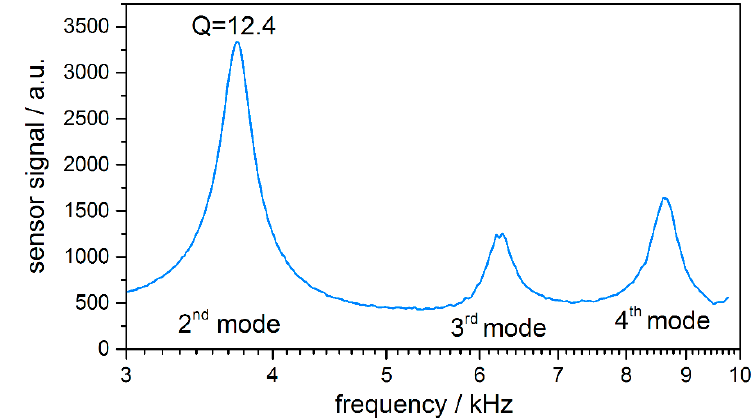
Figure 2. Frequency resposnse of the resonant photoacoustic cell. The second resonator mode gives the best signal and has a Q-factor of around 12.4.